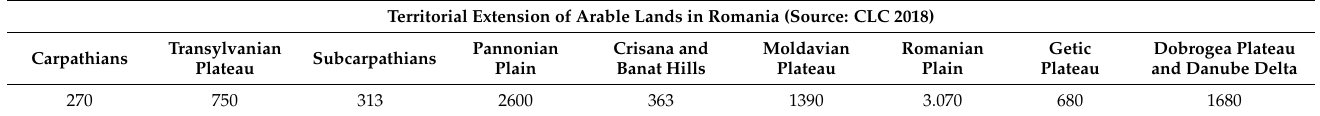
Table 1. Territorial extension of arable lands according to CLC 2018 in the main regions of Romania (thousands of hec- tares).